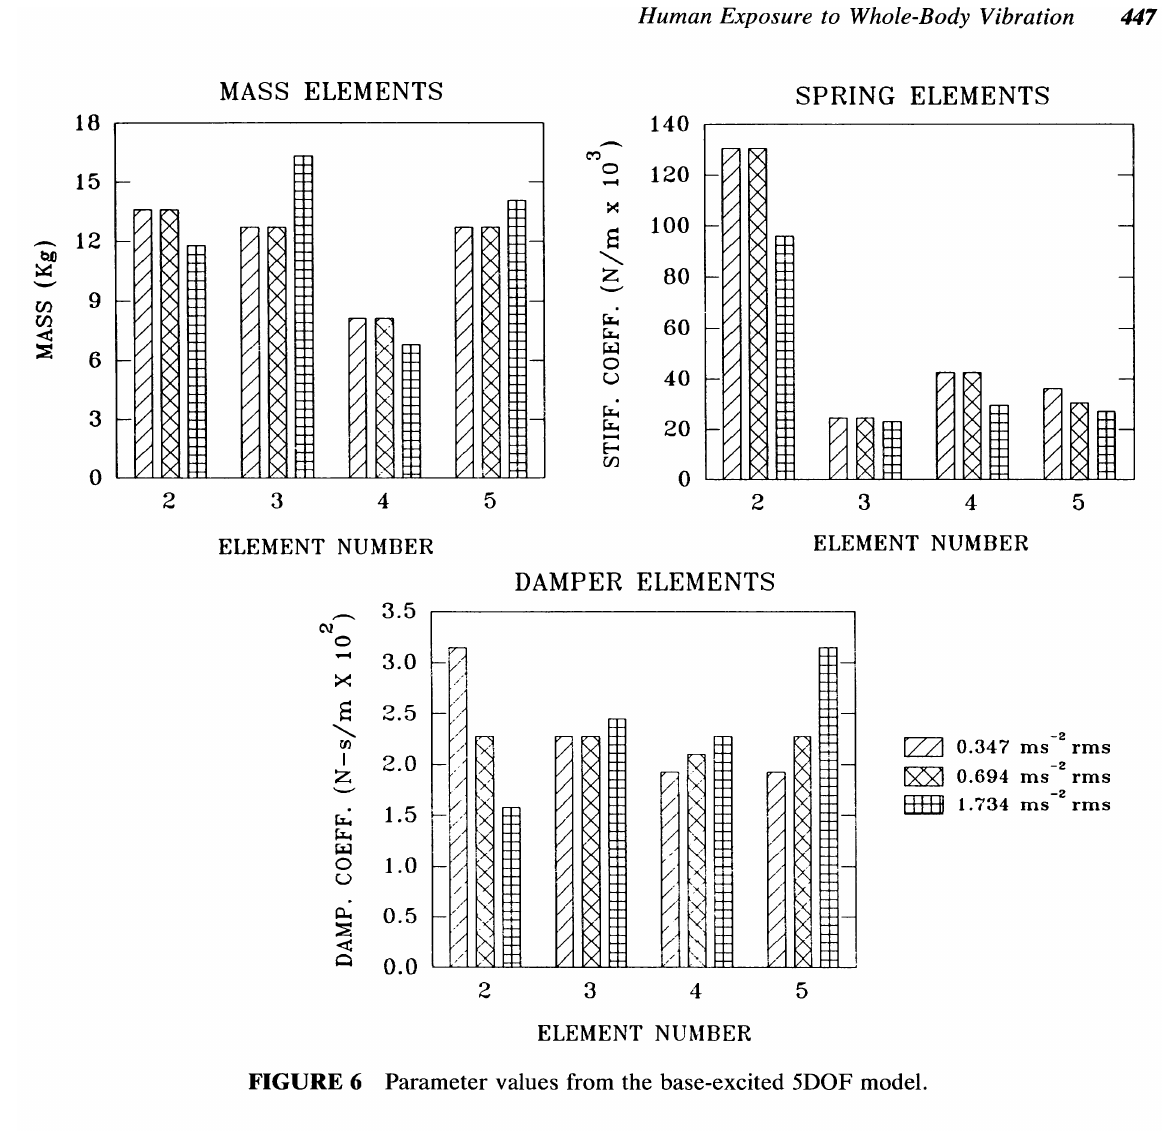
FIGURE 6 Parameter values from the base-excited 5DOF